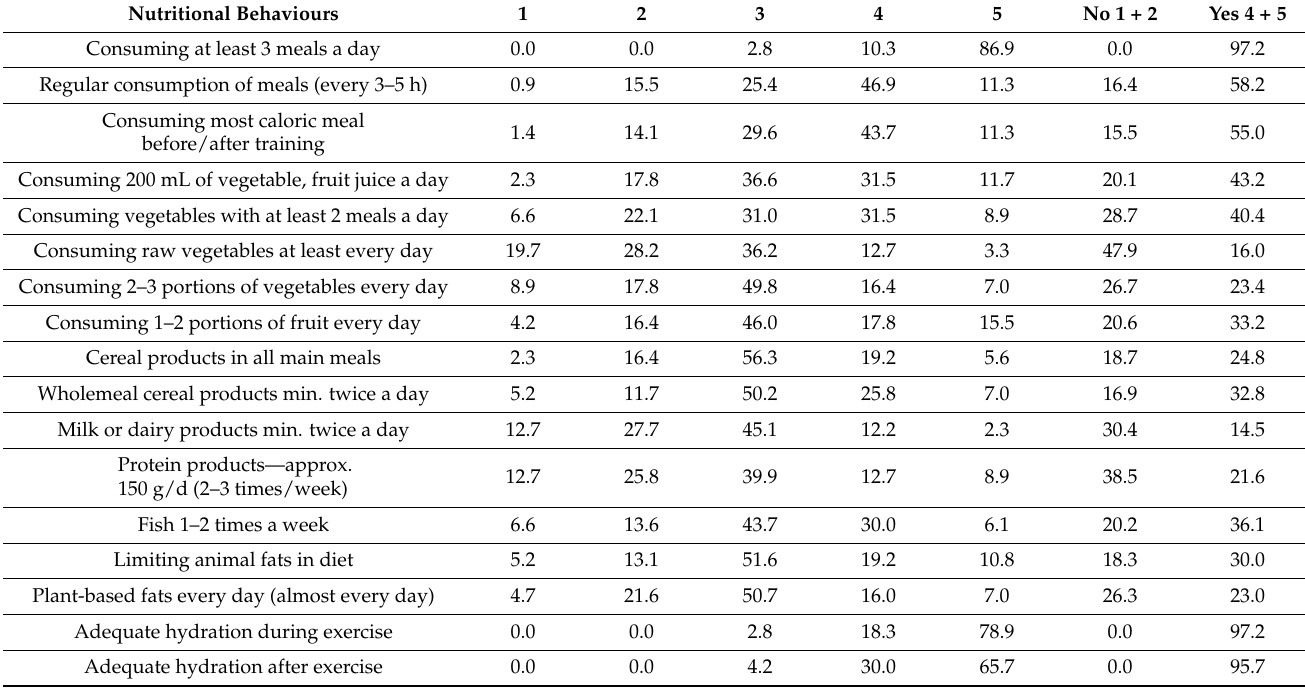
Table 1. Implementing recommendations of the Swiss pyramid among athletes training in team sports (% of